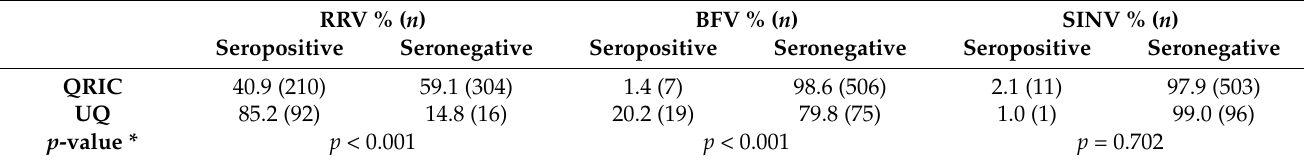
Table 3. Outcome summary of alphaviruses